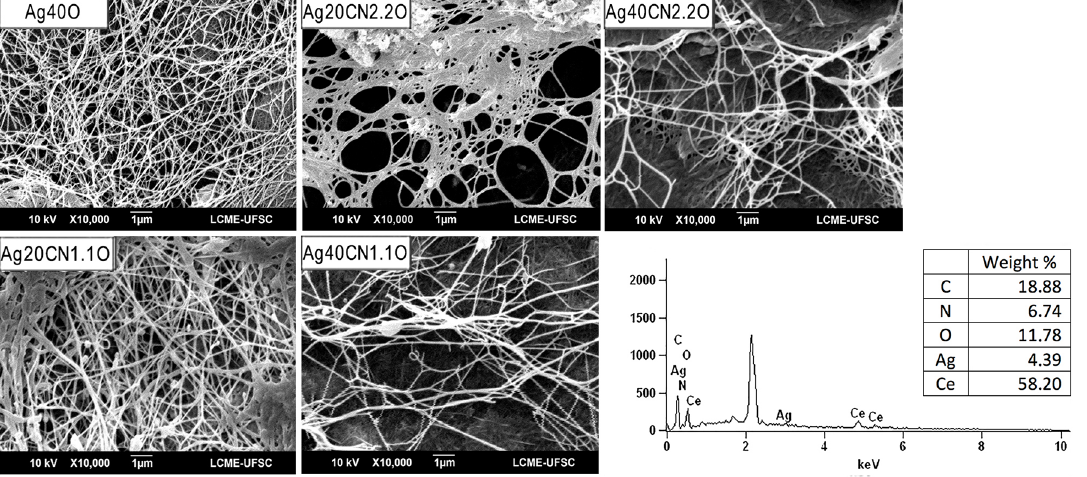
Figure 9. Micrographs obtained by scanning electron microscopy of the upper surface of the functionalized BC membranes submitted to a thermal treatment in autoclave, and EDS analysis of sample